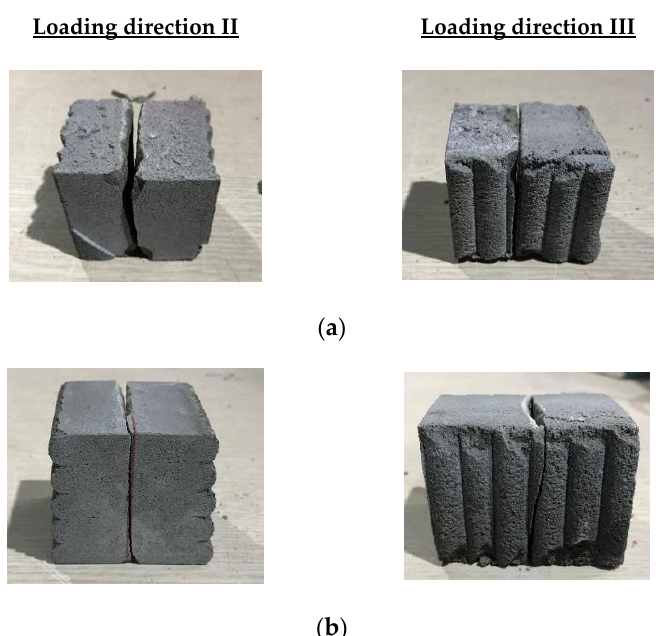
Figure 18. Splitting tensile failure patterns of mortar samples under loading directions II and III. ( a ) Water-cured specimens; ( b ) Air-cured specimens.